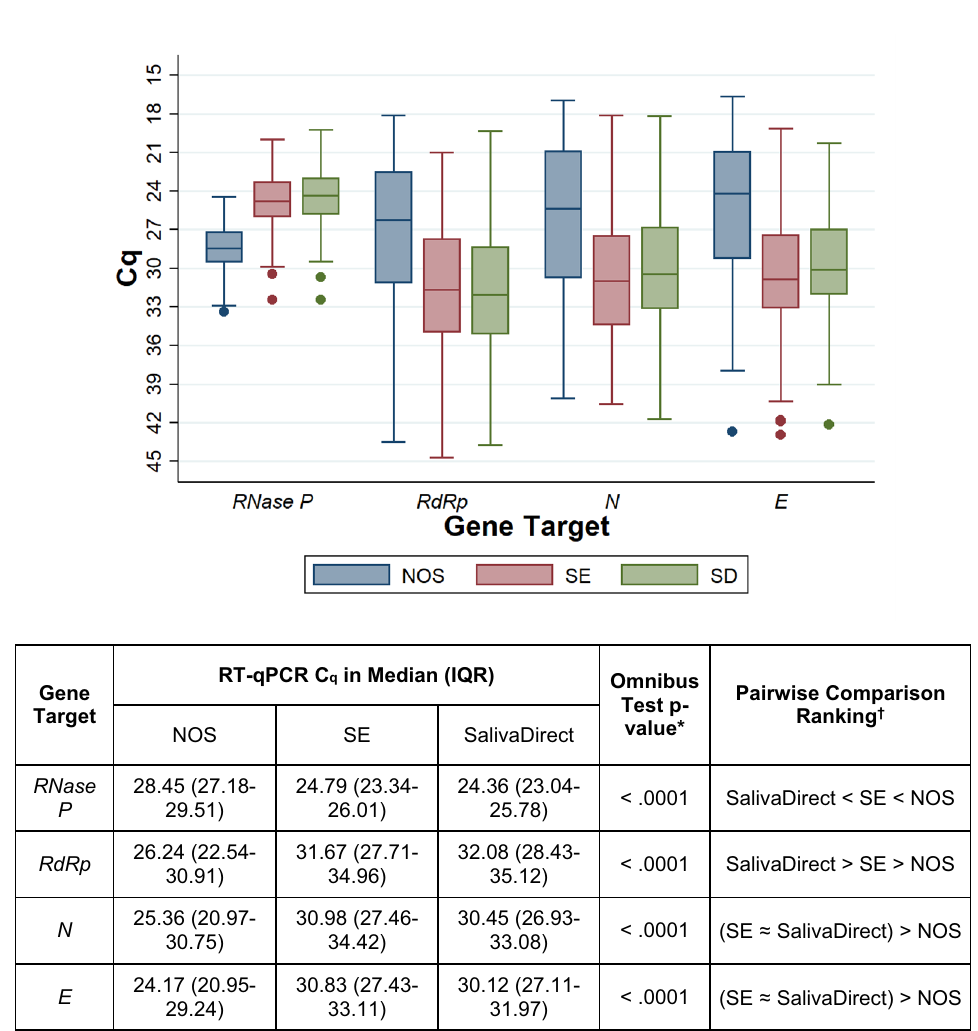
Figure 2. RT-qPCR C q values from NOS, SE and SalivaDirect sample trios among study volunteers with positive reading on at least one test (n = 160). C q quantification cycle, E envelope, IQR interquartile range, N nucleocapsid, NOS naso-oropharyngeal swab, RdRp RNA-dependent RNA polymerase, RT-qPCR reverse transcription quantitative/real-time polymerase chain reaction, SE saliva with RNA extraction. * Through Skillings-Mack test. † Through Wilcoxon signed-rank test with Bonferroni correction (adjusted threshold for statistical significance: p corrected ≤